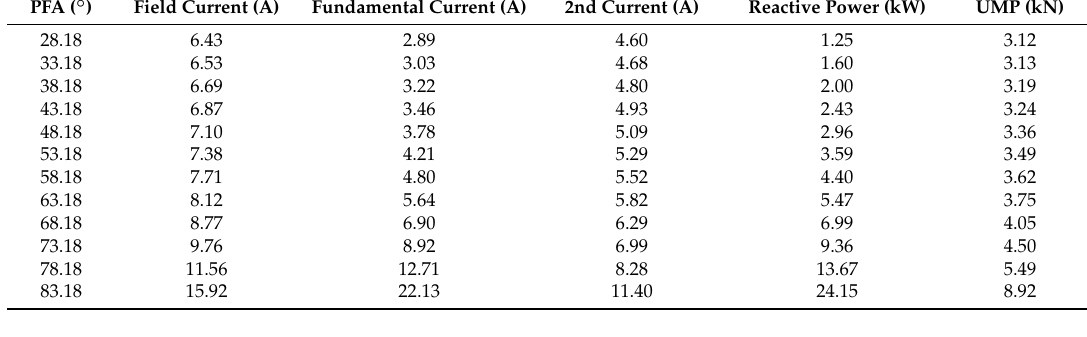
Figure 16. Relationship between UMP and output active power.